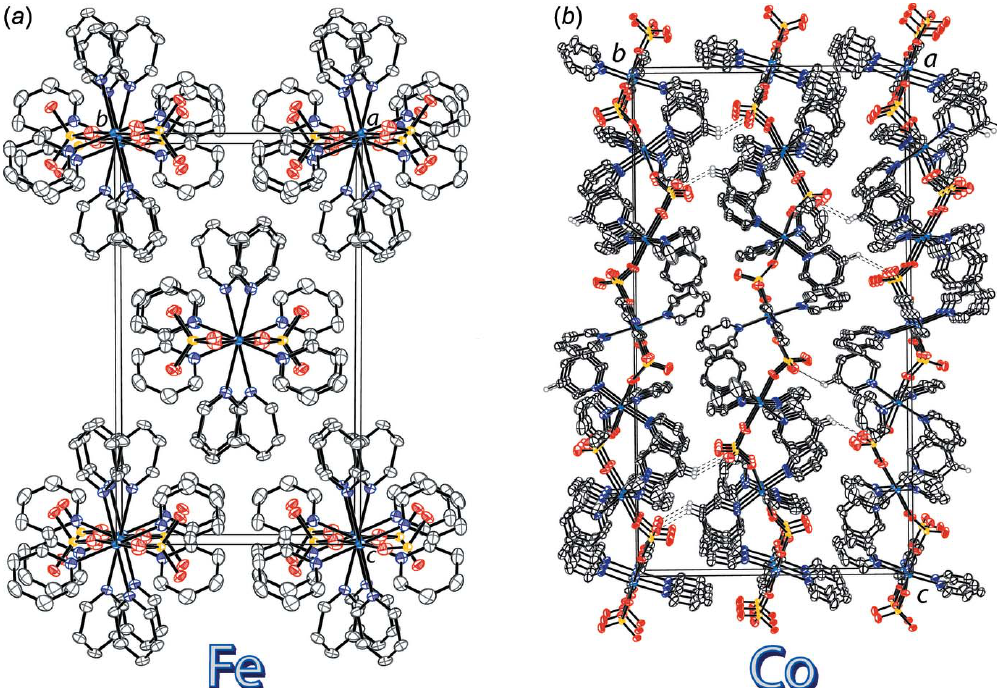
Figure 4 The packing of ( a ) compound ( 1 ) and ( b ) compound ( 2 ) along the a axis. Displacement ellipsoids are drawn at the 50% probability level. In ( 2 ), H atoms are omitted for clarity in compound ( 1 ). H atoms involved in hydrogen bonding between chains are drawn as spheres of arbitrary radius, with the other H atoms omitted for clarity. C—H (cid:3)(cid:3)(cid:3) O interactions (Table 2) are shown as dashed